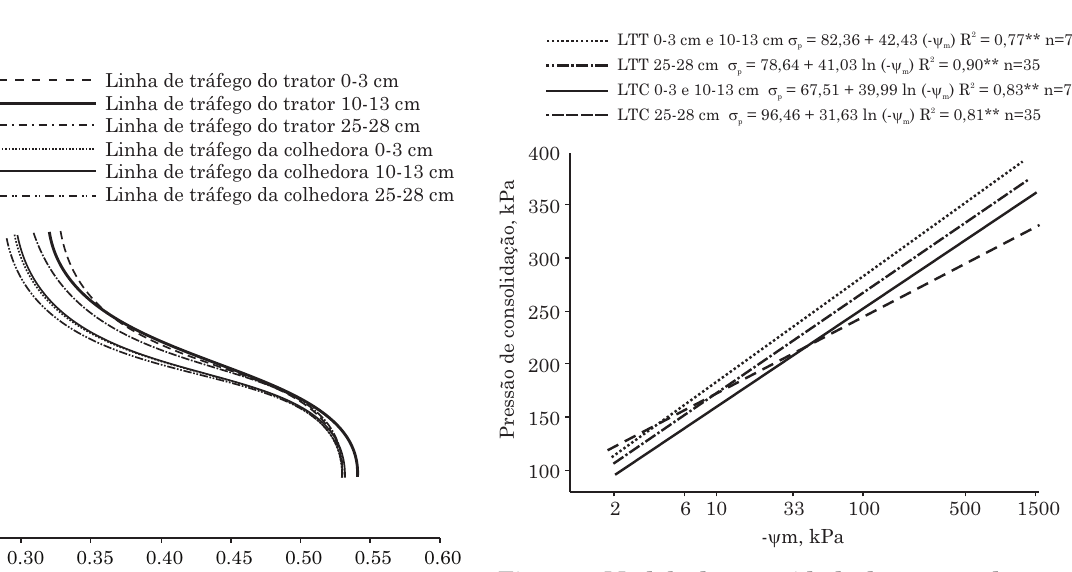
Figura 2. Modelo de capacidade de suporte de carga em função do potencial matricial (- ψψψψψ m ) em um Latossolo Vermelho-Amarelo (LVA) para a linha de tráfego do trator (LTT) e linha de tráfego da colhedora (LTC), em três camadas sob a cultura do